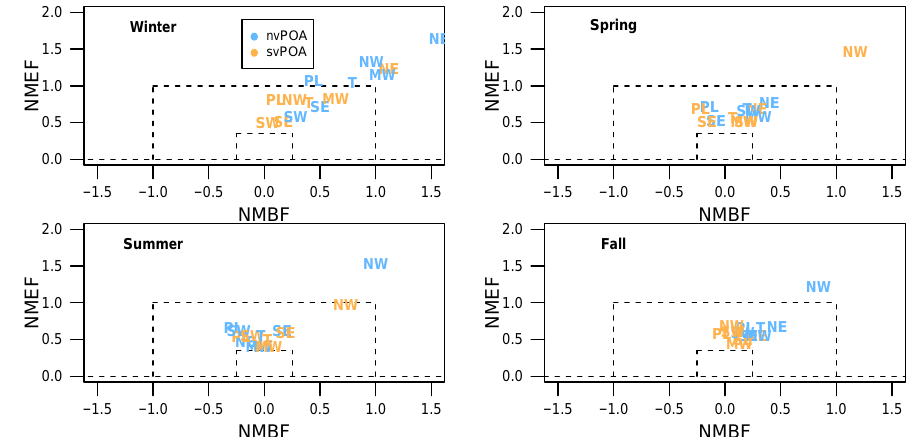
Figure 10. Regional and seasonal model performance at routine-monitoring stations for the CONUS11 simulation as a function of the normalized mean bias factor (NMBF) and normalized mean error factor (NMEF) for OC predictions. Plotted regions include the northeast (NE), Midwest (MW), southeast (SE), Plains (PL), northwest (NW), southwest (SW), and total (T) and are defined as visualized in Fig. 8.